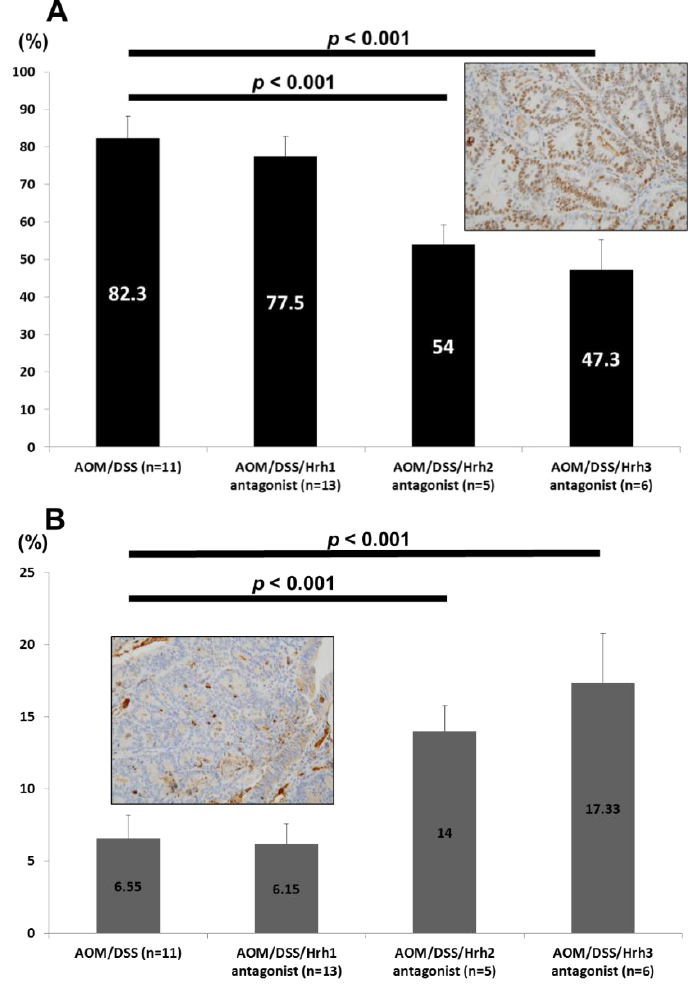
Figure 2. ( A ) Proliferating activities estimated by the MCM2-positive rate of cancer cells in Groups 1 through 4. Insert: MCM2 immunohistochemistry of adenocarcinoma developed in a mouse belonging to Group 1; ( B ) Apoptosis estimated by the caspase 3-positive rate of cancer cells in Groups 1 through 4. Insert: Caspase 3 immunohistochemistry of adenocarcinoma developed in a mouse belonging to Group 1.